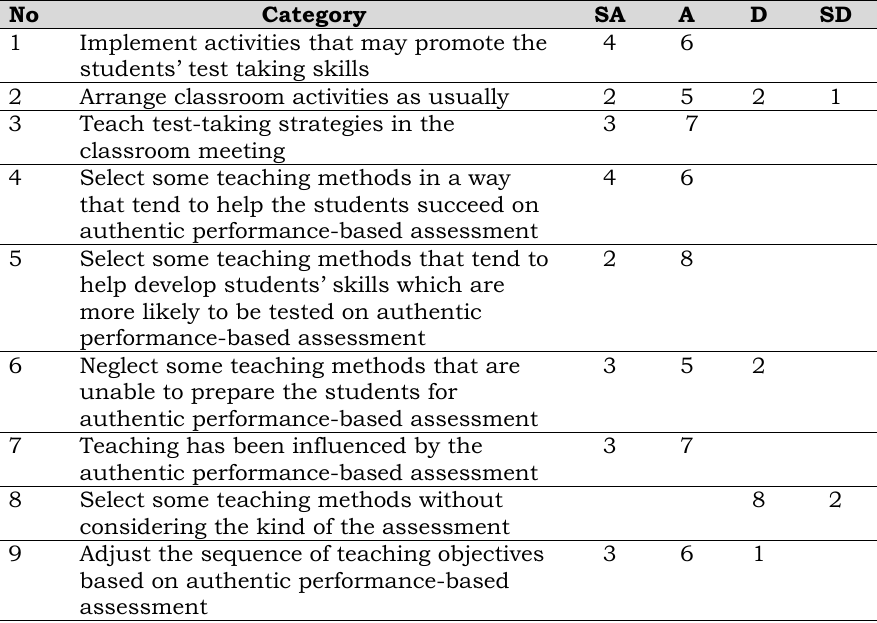
Washback Effect on Teaching